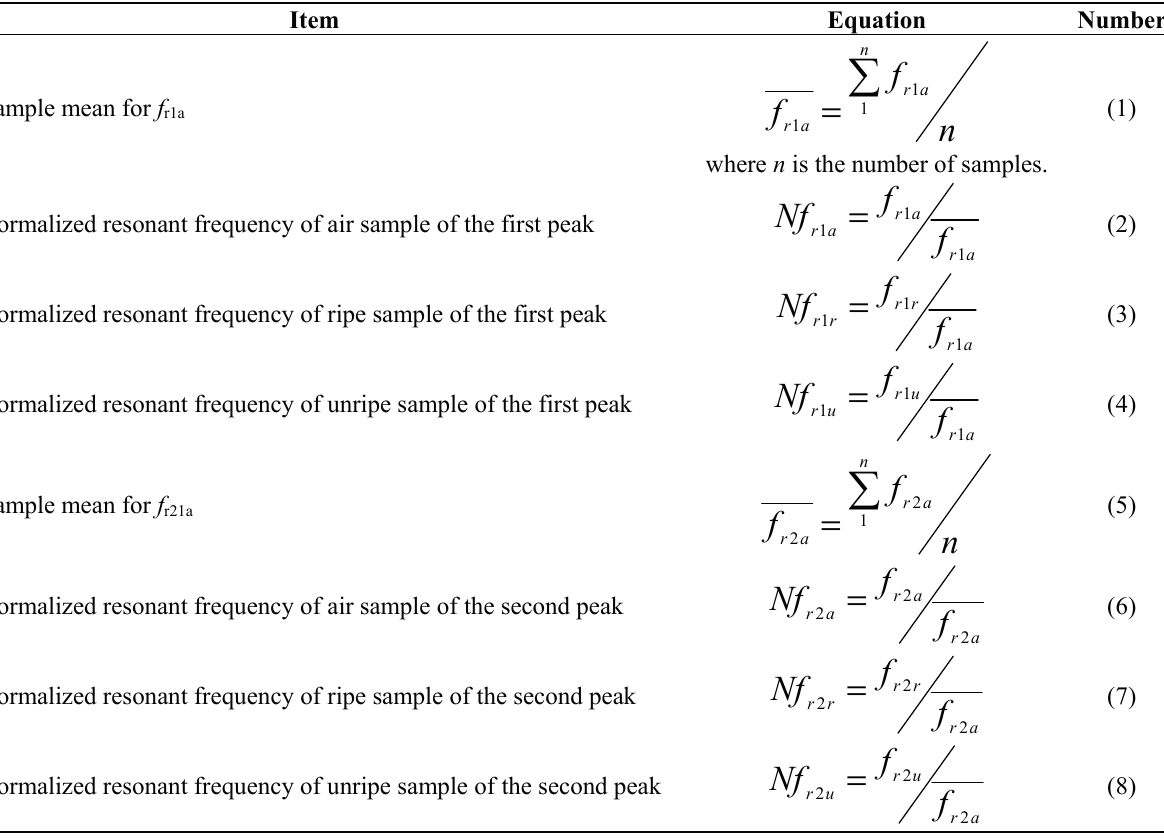
Table 4. List of equations for the dual resonant